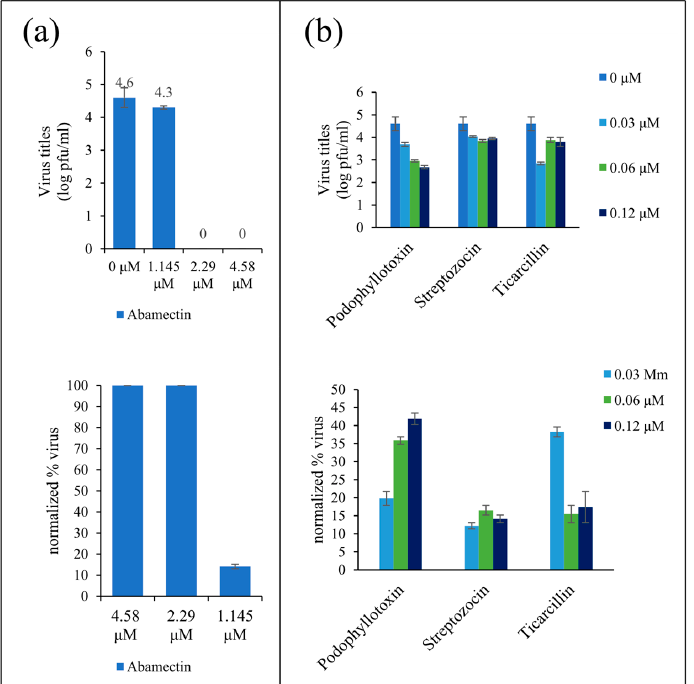
Figure 5. The effect of four agents on virus titer. ( a ) The JEV titers and inhibition rate on JEV in the presence of different concentrations of Abamectin. ( b ) The JEV titers and inhibition rate of various agents on JEV. Data are mean ± standard deviation of three independent replicates.